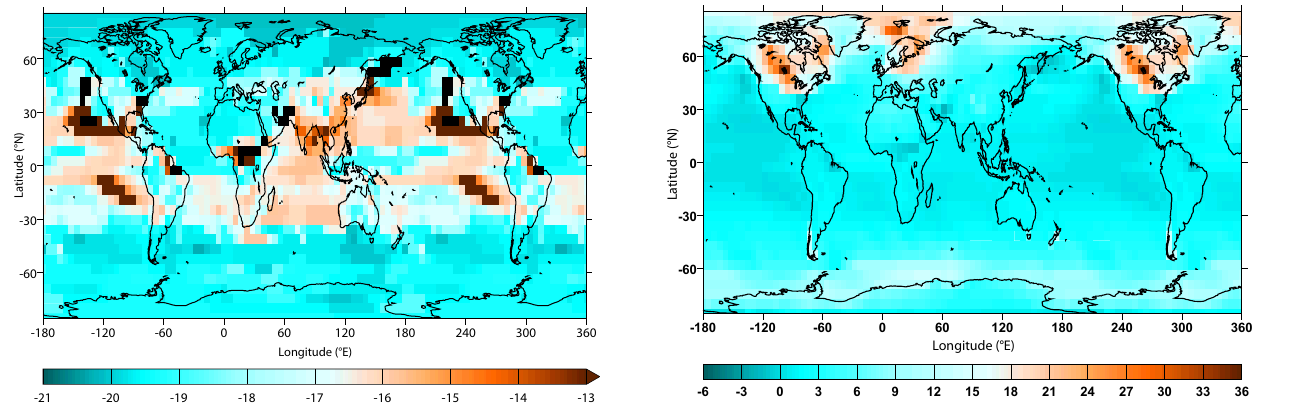
Fig. 4. Timing of first significant warming during the deglaciation from a 100 yr sample at 5% significance. Color scale is the date inkyrs BP Black denotes regions without significant warming over the deglaciation.